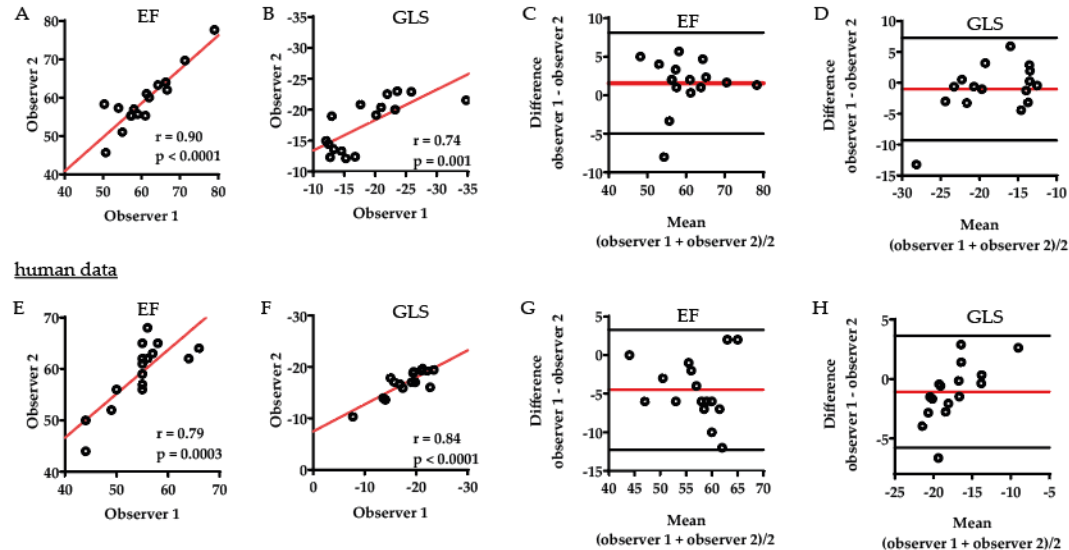
Figure 5. Interobserver comparison. In analysis by two experts, variability comparison showed moderate to strong correlation between the assessments for animal EF ( A ) and GLS ( B ) with a moderate bias, as shown in the Bland–Altman plots, mean difference (95% CI for limits of agreement) of 1.56 (−4.96 to 8.09) for animal EF ( C ) and −1.01 (−9.30 to 7.28) for animal GLS ( D ). A moderate to strong correlation was also shown between the assessments of the two observers for human EF ( E ) and GLS ( F ) with a moderate bias, as shown in the Bland–Altman plots, mean difference of −4.50 (−12.27 to 3.27) for human EF ( G ) and −1.08 (−5.79 to 3.64) for human GLS ( H ).